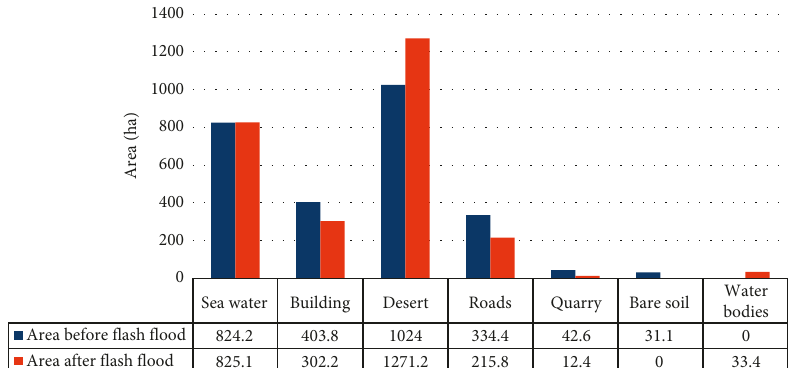
Figure 9: The destroyed area of each category in hectare (ha).